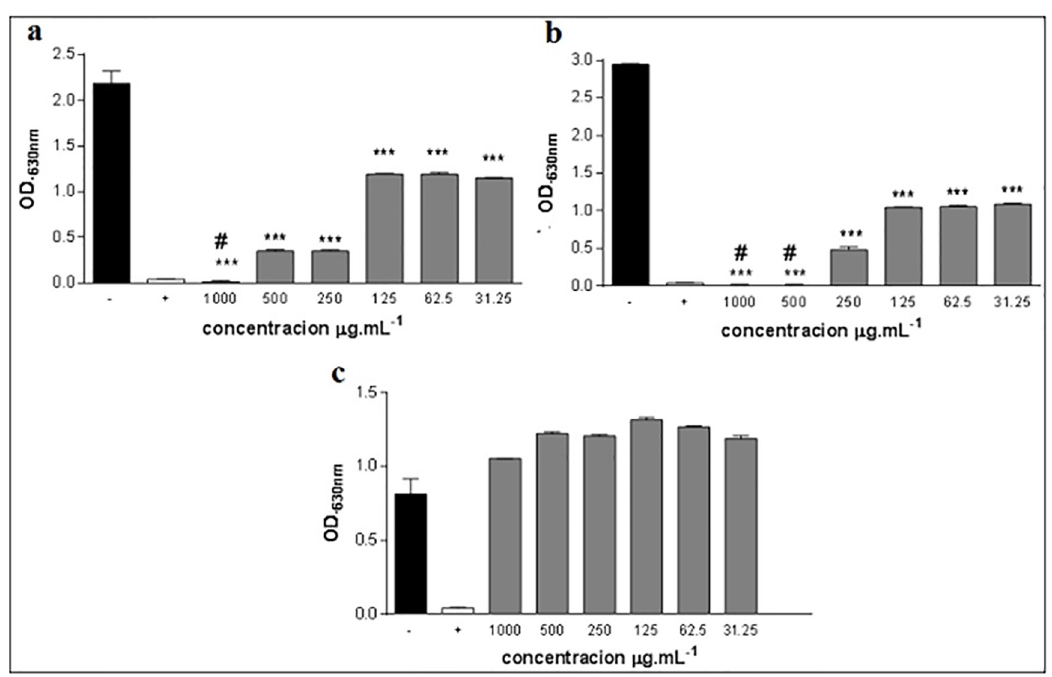
Fig 2. This is the figure of Minimum Inhibitory Concentration (MIC) and Minimum Bactericidal Concentration (MBC) of O . majorana L. essential oil. a) EO O . majorana L. against P . aeruginosa ATCC 25922. b) EO O . majorana L. against E . coli ATCC 8789. c) EO O . majorana L. against S . aureus ATCC 25922. Test substance of essential oil of the O . majorana L. ( ), BHI with 2% of DMSO ( & ) and Amoxiline ( □ ); ��� P < 0.001 statistically significant in relation to the negative control; # p < 0.001 statistically significant in relation to the positive control.